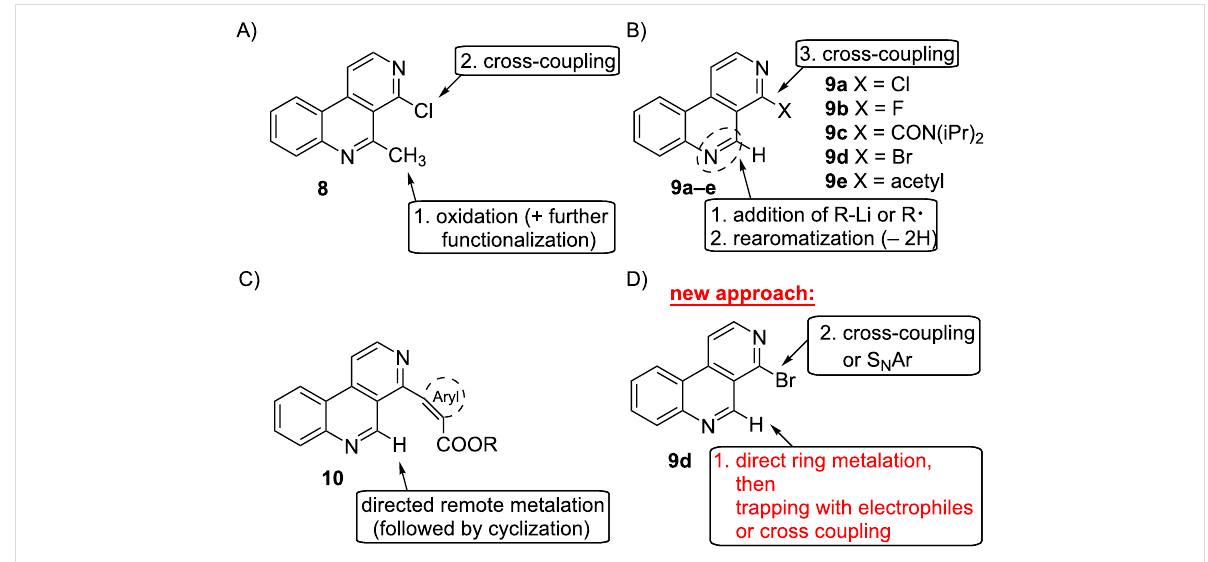
Figure 2: A–C): Published methods for the synthesis of 4,5-disubstituted benzo[ c ][2,7]naphthyridines; D) New approach.